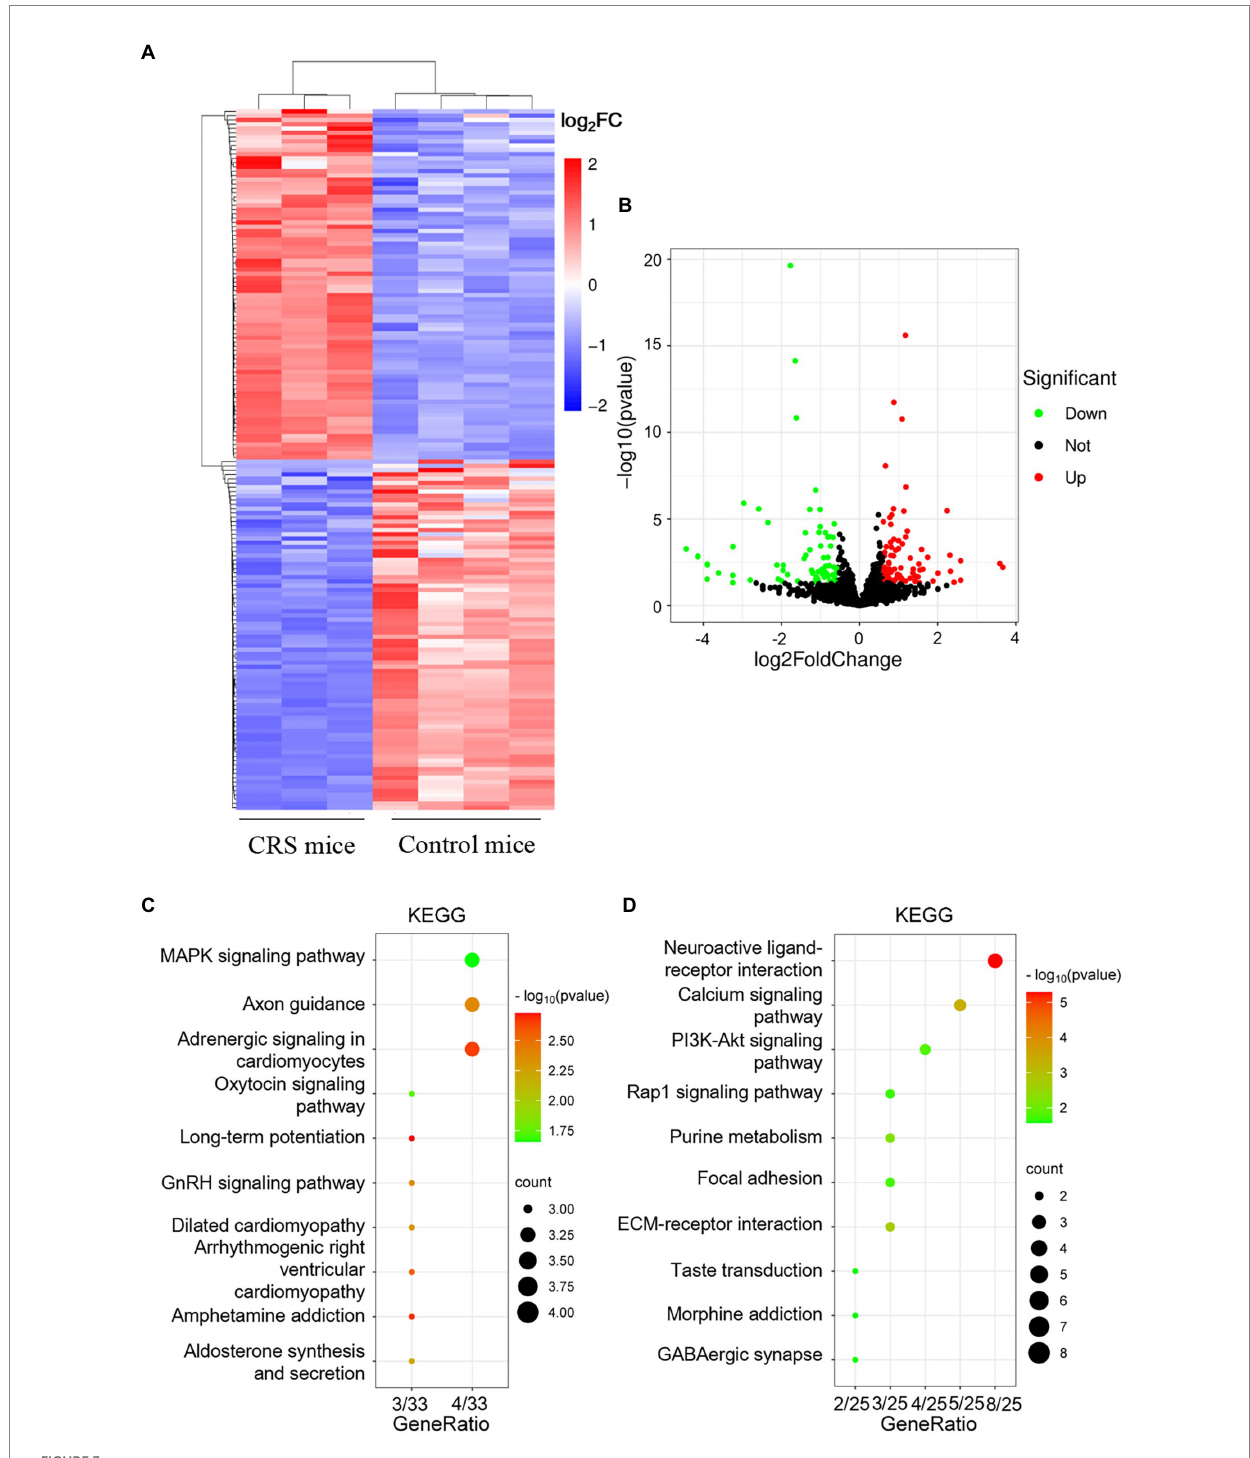
FIGURE 3 mRNA expression profile analysis of the hippocampus in control mice and CRS-treated mice. (A) The heatmap of DEGs between Control mice and CRS-treated mice. (B) The volcano map of genes between Control mice and CRS-treated mice. (C,D) The KEGG enrichment analysis of up-regulated genes (C) and down-regulated genes (D)